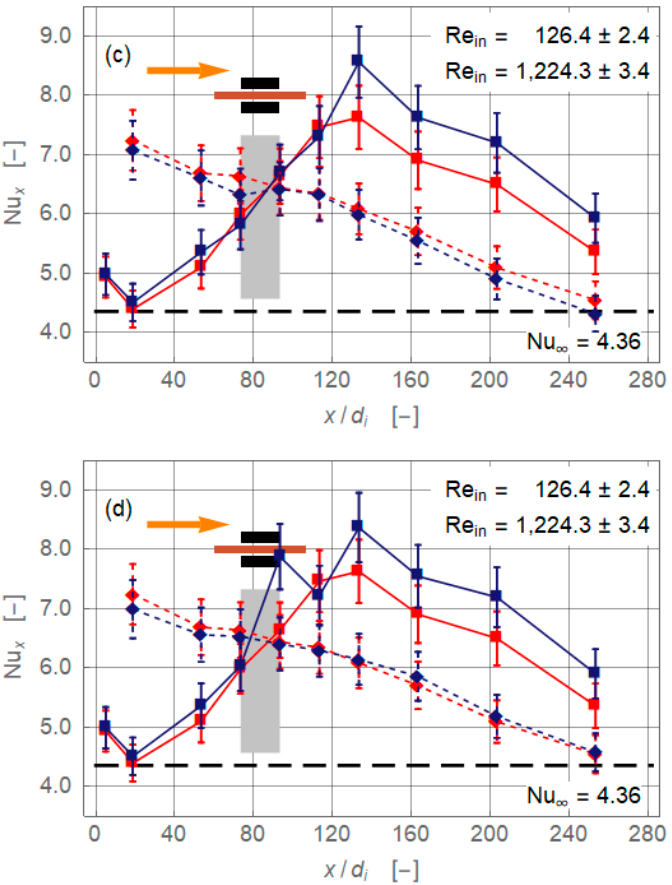
Figure 7. Comparison Local Nusselt number along non-dimensional axial coordinate for the magnet configurations single magnet below and above and two attracting magnets ( r cl = 34 mm). The plots show ( a ) magnet below pipe, ( b ) magnet above pipe, ( c ) magnets below and above pipe attracting each other, and ( d ) magnets below and above the pipe repulsing each other. Squares indicate Re in = 126.4 ± 2.4 and lozenges Re in = 1224.4 ± 3.4.